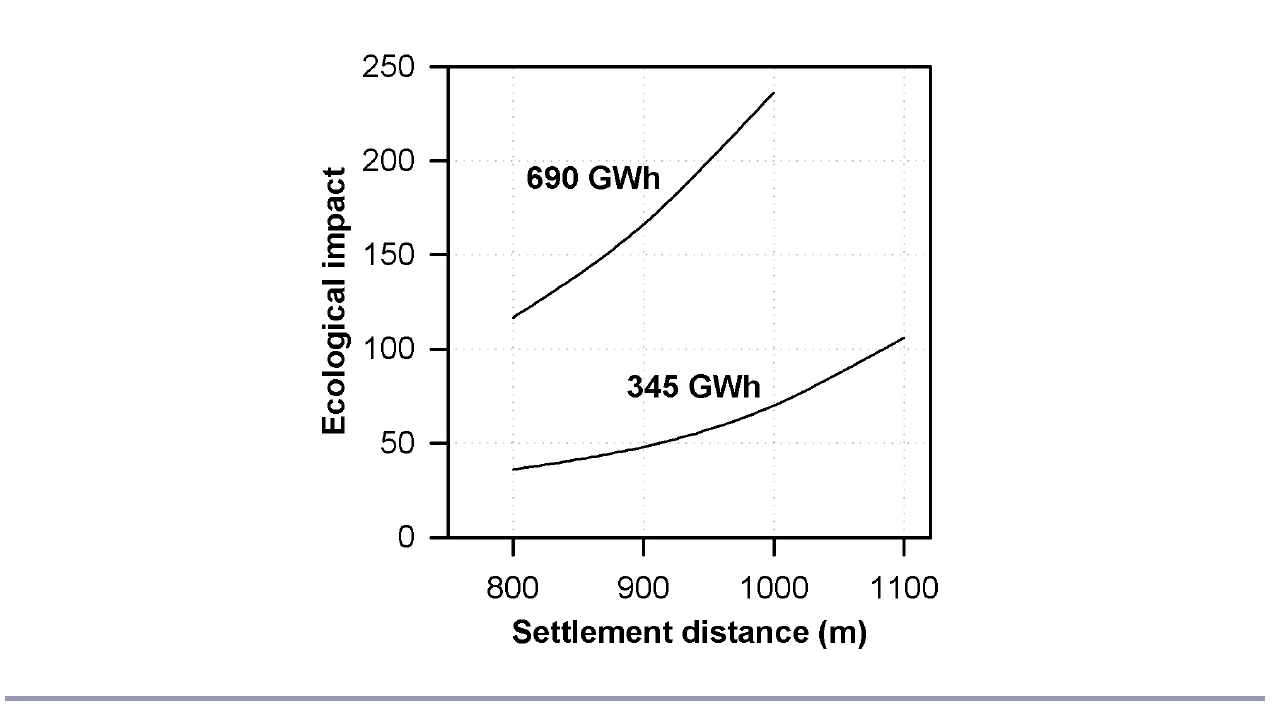
Fig. 8 . Efficiency frontier. Impact value versus settlement distance. Upper line: energy production of 690 GWh; lower line: energy production of 345